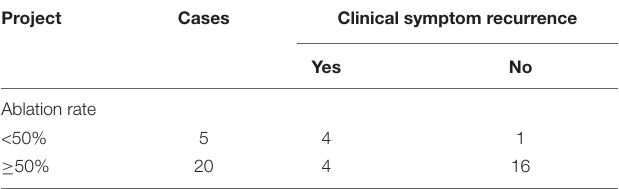
TABLE 8 | Ablation rates and clinical symptom recurrence in 25